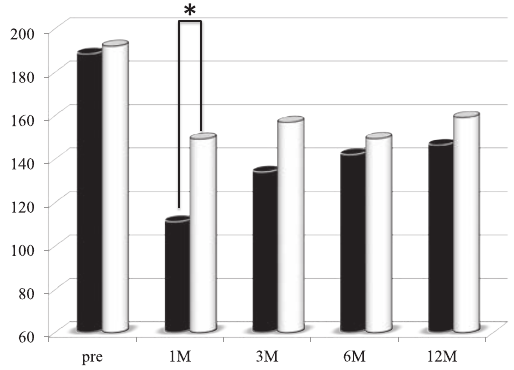
Figure 2 Changes in total lymphocytes counts in patients who underwent pancreaticoduodenectomy in the first period (with low-titer digestive enzyme preparations) versus the second period (with high-titer pancrelipase) There was no significant intergroup difference in the total lymphocyte count.